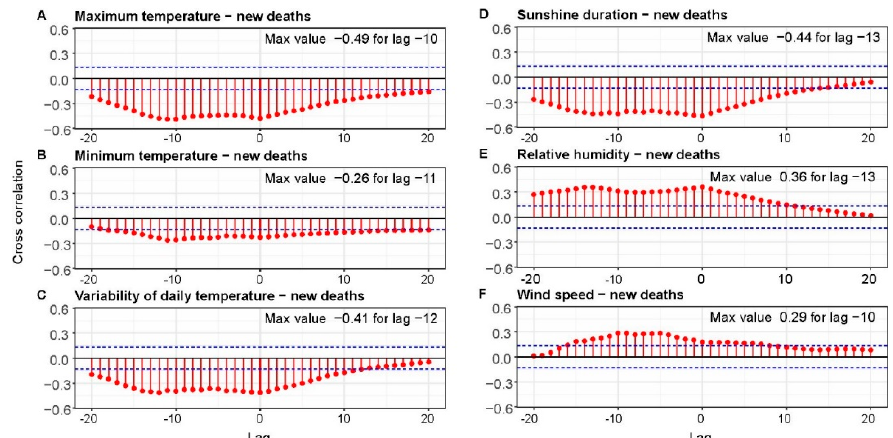
Figure 6. Cross-correlation between number of new deaths and meteorology parameters: maximum daily temperature ( A ), minimum daily temperature ( B ), variability of daily temperature ( C ),sunshine duration ( D ), relative humidity ( E ), wind speed ( F ). The 95% confidence bounds are plotted in blue.